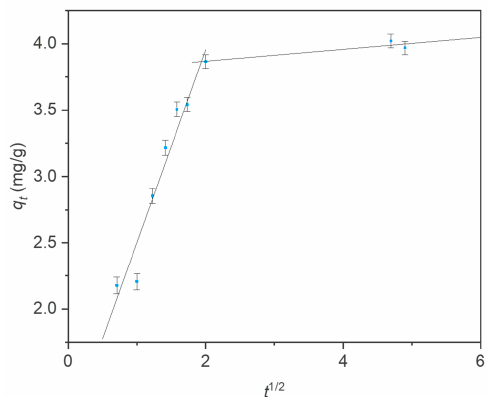
Figure 8. Application of intraparticle diffusion model for the adsorption of phenols in OMW onto PDMS/oxMWCNTs sponges. The lower value of k p2 with respect to k p1 (with k p1 and k p2 representing k p values for step I and II, respectively) indicated that the free path available for diffusion of PCs inside the sponge became